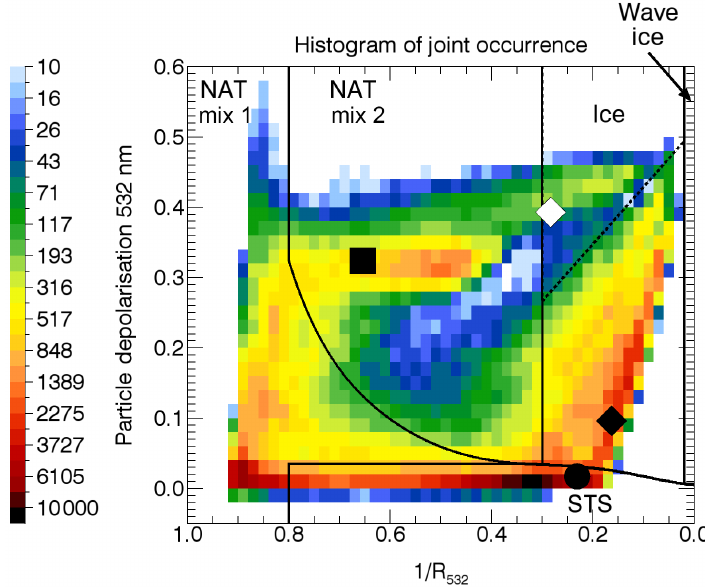
Figure 4. Composite 2-dimensional occurrence histogram of the PSC observed on 22 January 2016 shown in Fig. 3 in the 1 / backscatter ratio versus particle depolarization ratio coordinate system. The solid black lines denote the boundaries of the PSC types defined by Pitts et al. (2011), with the threshold between ice and NAT Mix2 1 /R ice = 0 . 3. The dotted line separates the high-depol and low-depol ice modes. The symbols indicate the starting points of trajectories within different PSC types (square: NAT Mix2, hollow diamond: high-depol ice, filled diamond: low-depol ice and circle: